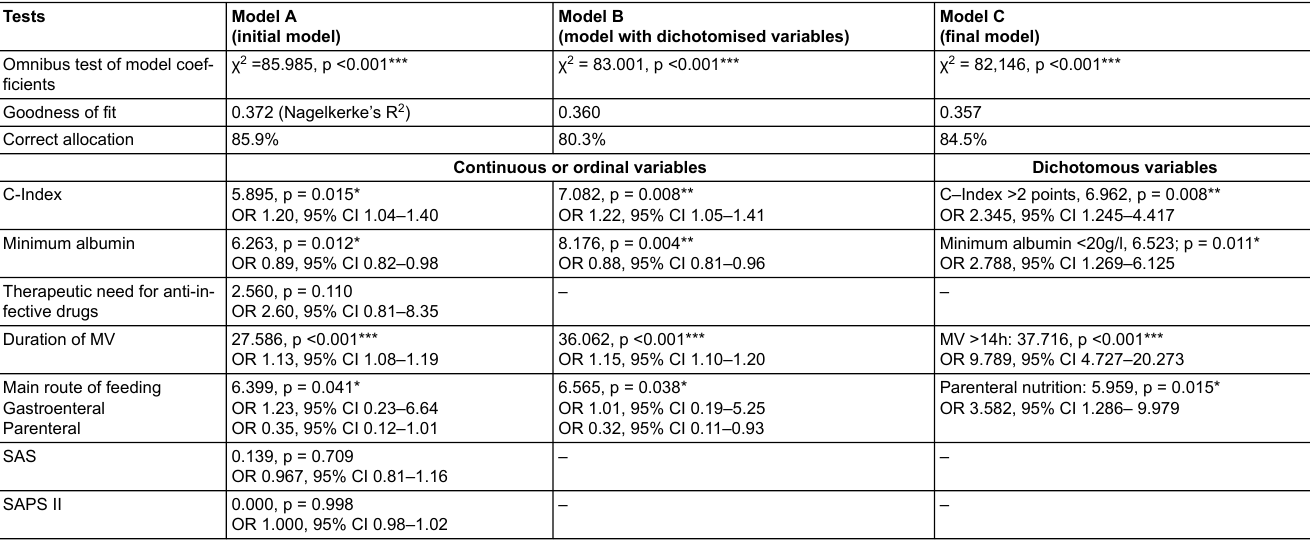
Table 3: Significance values of the steps of logistic regression analyses in the model in development sample (n = 304).